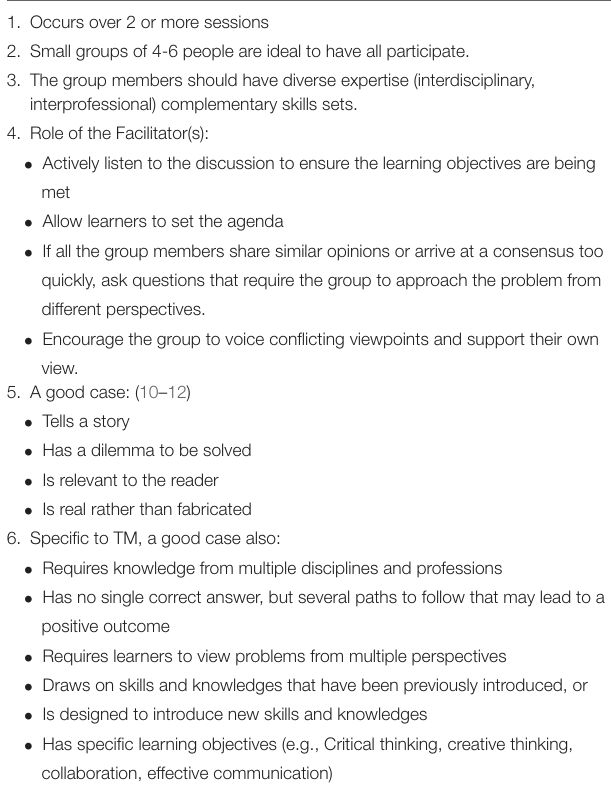
TABLE 2 | Key points of the hidden curriculum. TABLE 3 | Key points of the unfolding